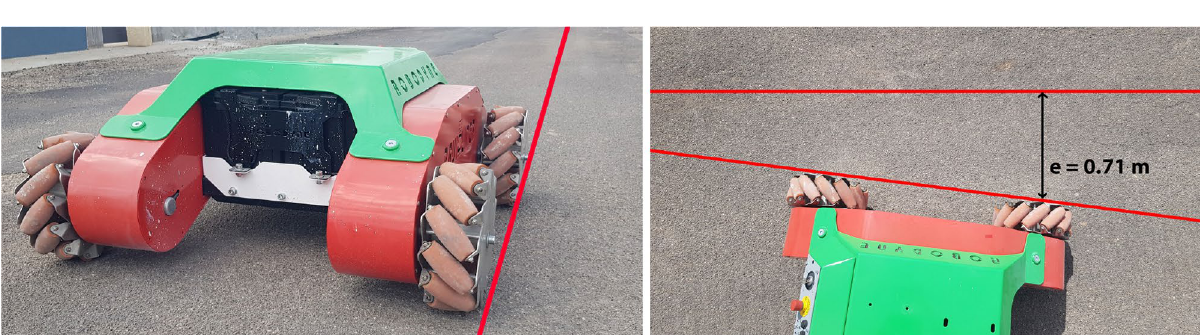
Figure 15. The vehicle positioned at the starting point on asphalt, on the left, and the final error at goal, on the